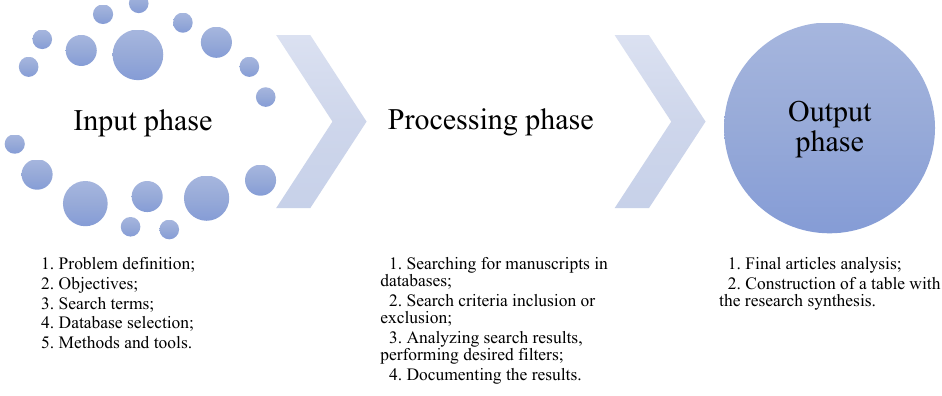
Figure 1. Model for conducting a systematic literature review. Adapted from